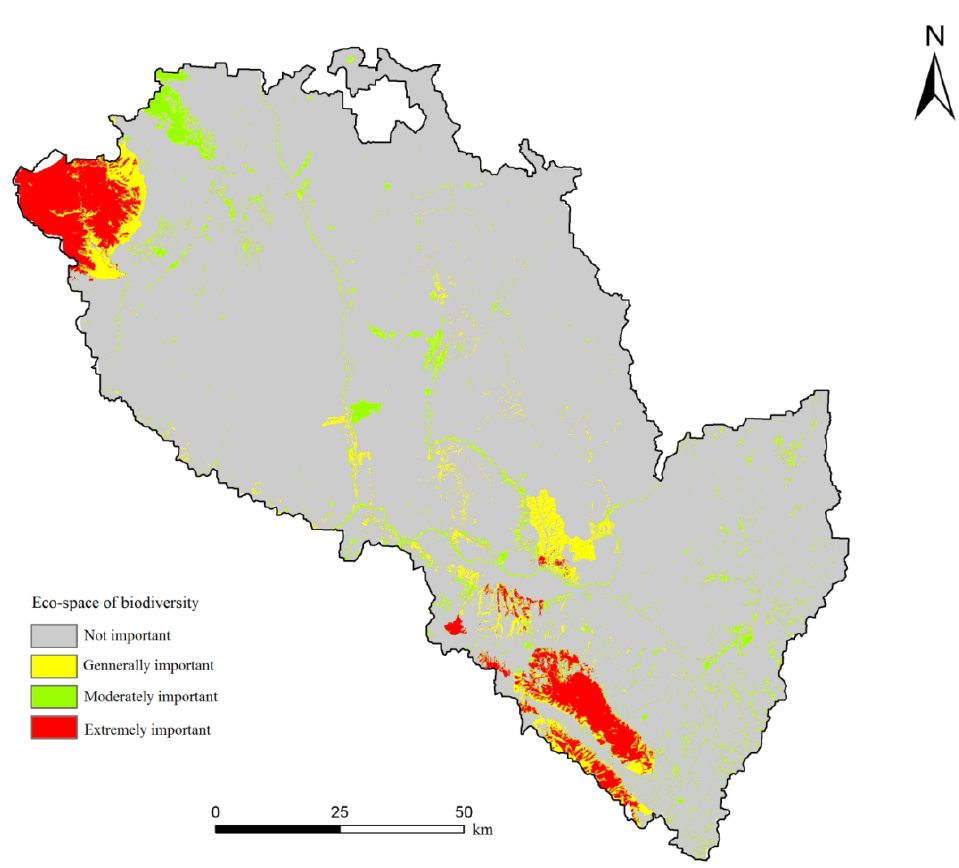
Figure 5. Evaluation results of the importance of biodiversity conservation eco-space in Lanzhou